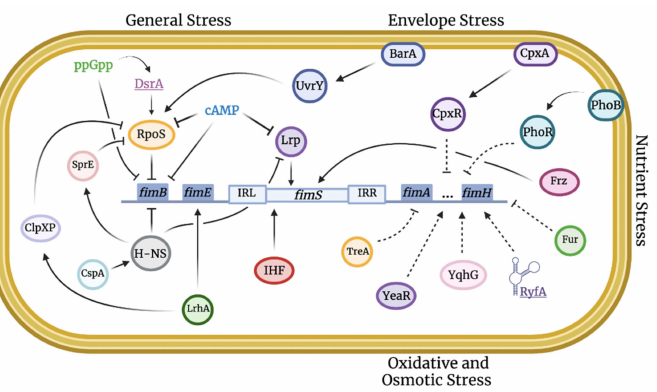
Figure 1. Integration map of stress-induced pathways implicated in type 1 fimbriae regulation. Stress regulation can be linked to virulence, such as the expression of type 1 fimbriae, through an intrinsic network of direct and indirect pathways. Solid lines indicate confirmed stimulatory or inhibitory effects. Dashed lines indicate unclear mechanisms that remain to be elucidated. Table 1. Global and specific stress response regulators involved in virulence and virulence gene expression in Escherichia coli